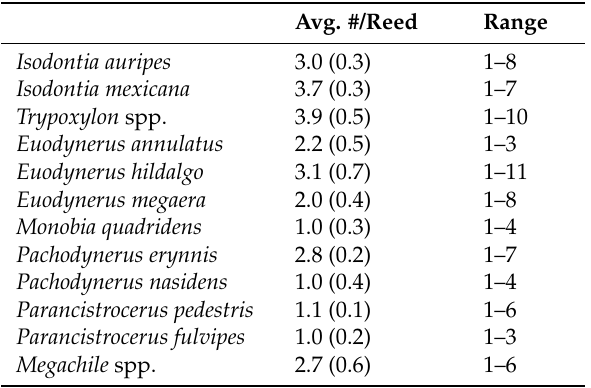
Table 3. Average # adults (SE) that emerged from reeds and ranges of adult emergences for common species/genera.